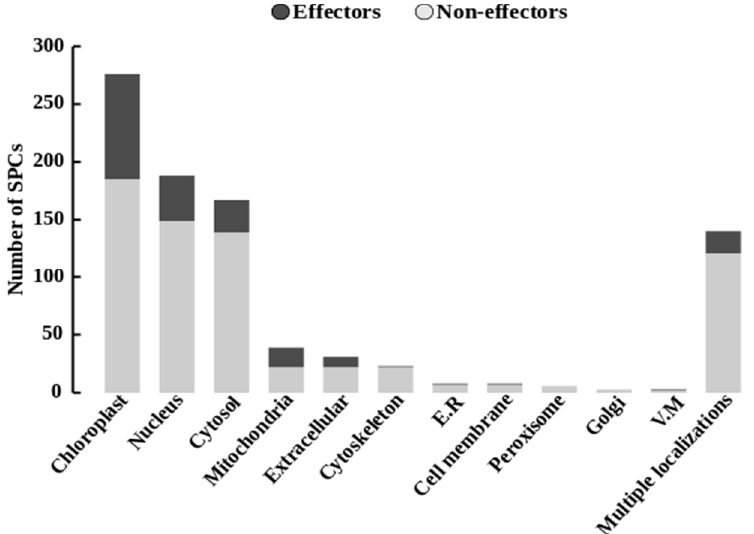
Figure 7. Expected subcellular targeting of SPCs in the plant cell. Bar graphs represent the predicted subcellular localization of putative secreted proteins (light gray), including the secreted putative effectors (dark gray). The pipeline used for the prediction of the secretion characteristics is described in Supplementary Figure S3.